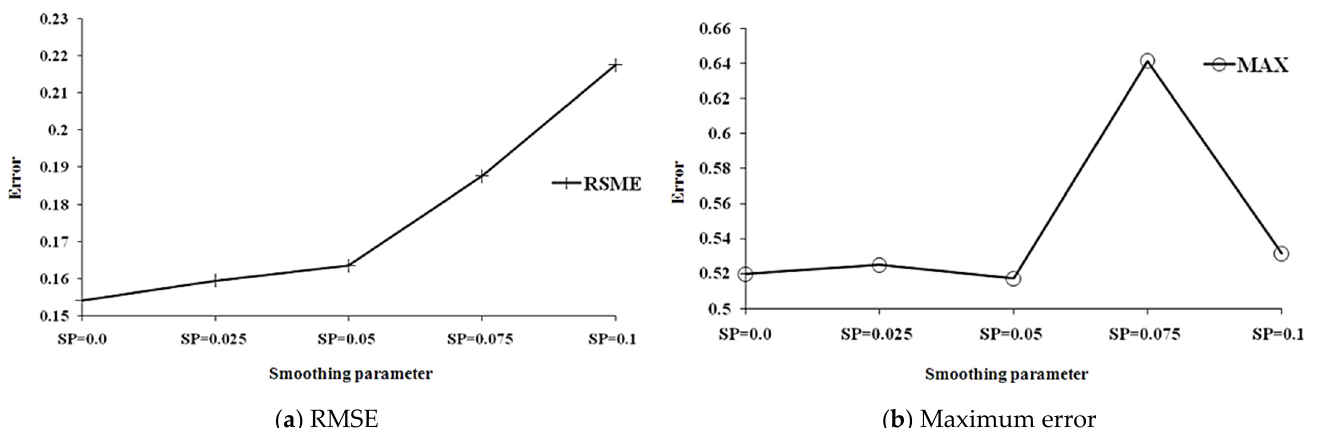
Figure 4. Performance comparison according to variation of SSP in Ackley’s path function.